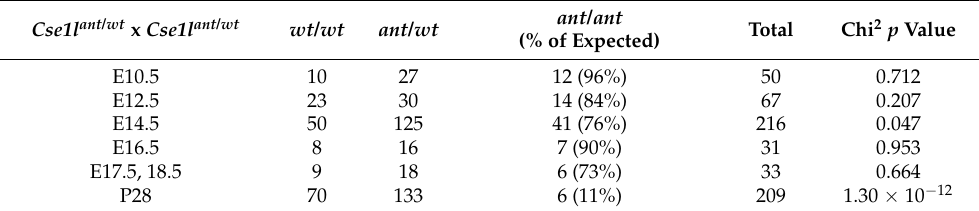
Table 1. Survival of anteater mutants. Cse1l ant/wt x Cse1l